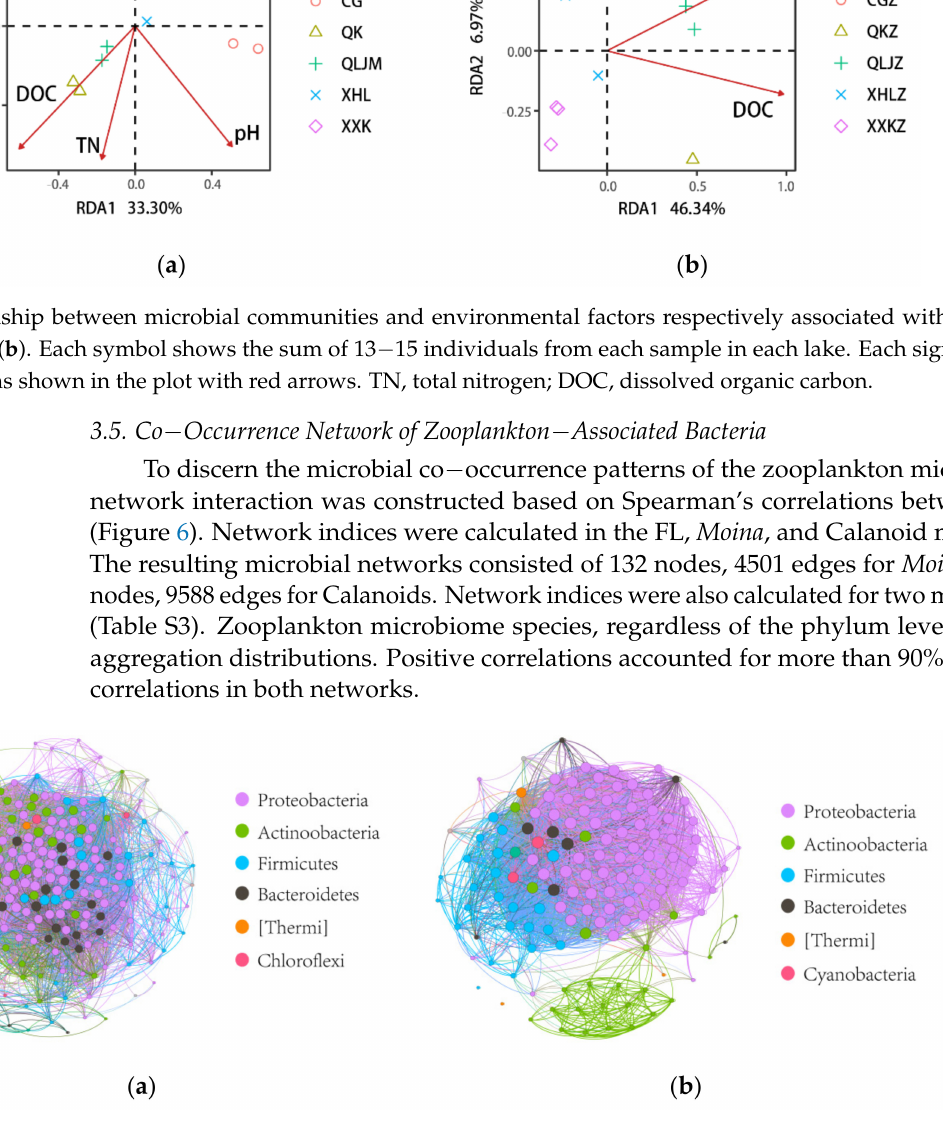
Figure 6. Co − occurrence network among different bacterial phyla associated with Calanoids ( a ) and Moina ( b ) are respectively shown. Different phyla are marked with different colors. Connections are shown by